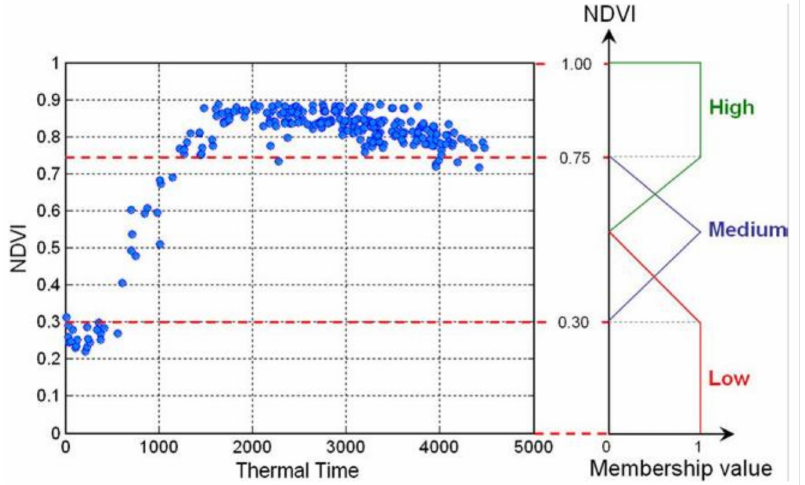
Figure 21. NDVI profile and thermal time described by El Hajj et al. [220]; Blue dots represent several sugarcane fields in Reunion, Island. Red dot lines are well separating the different membership